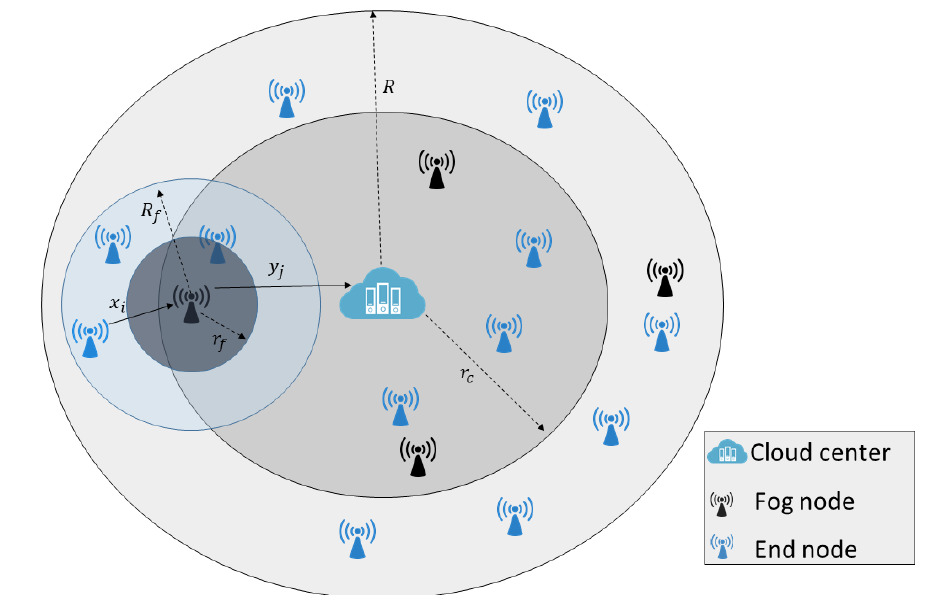
Figure 1. Illustration of the F-RAN